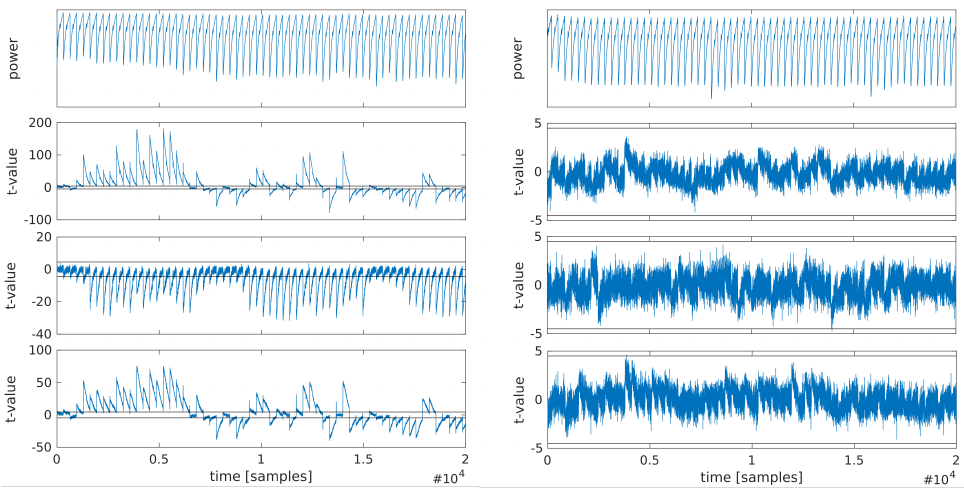
Figure 9: Non-specific leakage detection test on 2.5 rounds of encryption of a second-order protected AES. Left: PRNG off; 12 000 traces. Right: PRNG on; 50 million traces. Rows(top to bottom): exemplary power trace, first-order, second-order, third-order